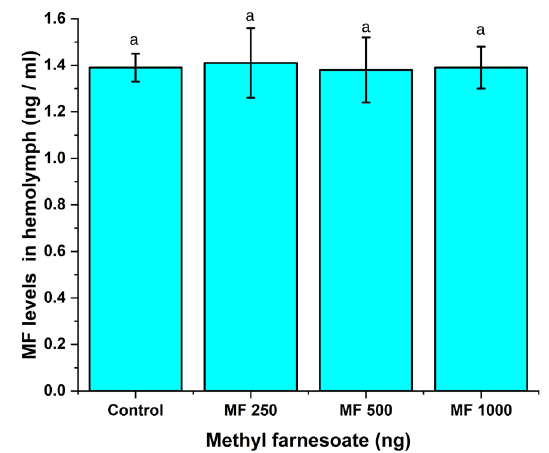
Figure 1. Effect of different dosages of MF on the MF concentration in the hemolymph of male Pontastacus leptodactylus . Letters indicate significant difference groupings ( P < 0.05) (mean ± S.D; n = 15).